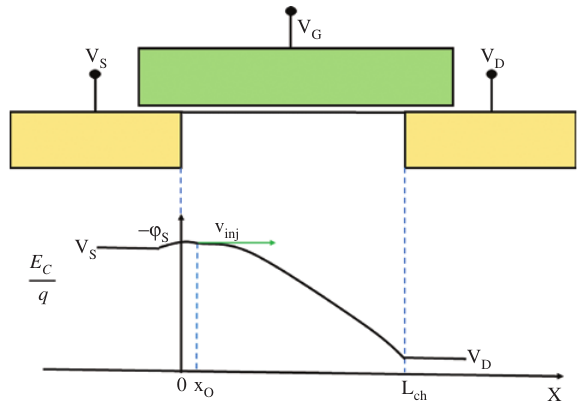
Figure 2: Simplified schematic of a MOSFET and the potential profile along the channel from source to drain when the device is on [9].